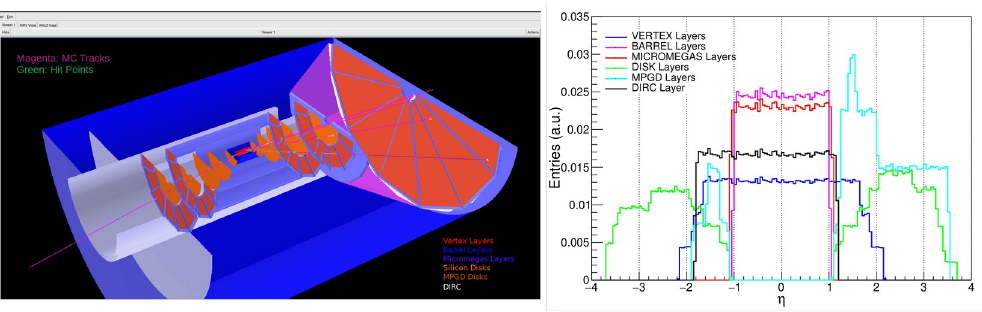
Fig. 1. (Left) Event Display of ATHENA showing the detector volumes with embedded pion MC tracks (magenta) and hits (green) using Fun4All simulation framework; (Right) Pseudorapidity coverage for each detector from the hit points on the detector